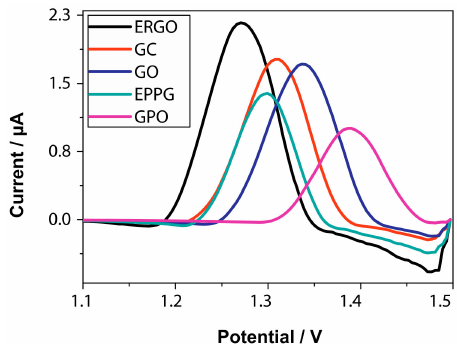
Figure 6. DPV profiles for the determination of ca ff eine (300 µ M in phosphate bu ff er, pH 7.2) of ERGO, GC (glassy carbon), GO, EPPG (edge plain pyrolytic graphite) and GPO (graphite oxide) electrodes. Reprinted with permission from [55]. Copyright 2013,